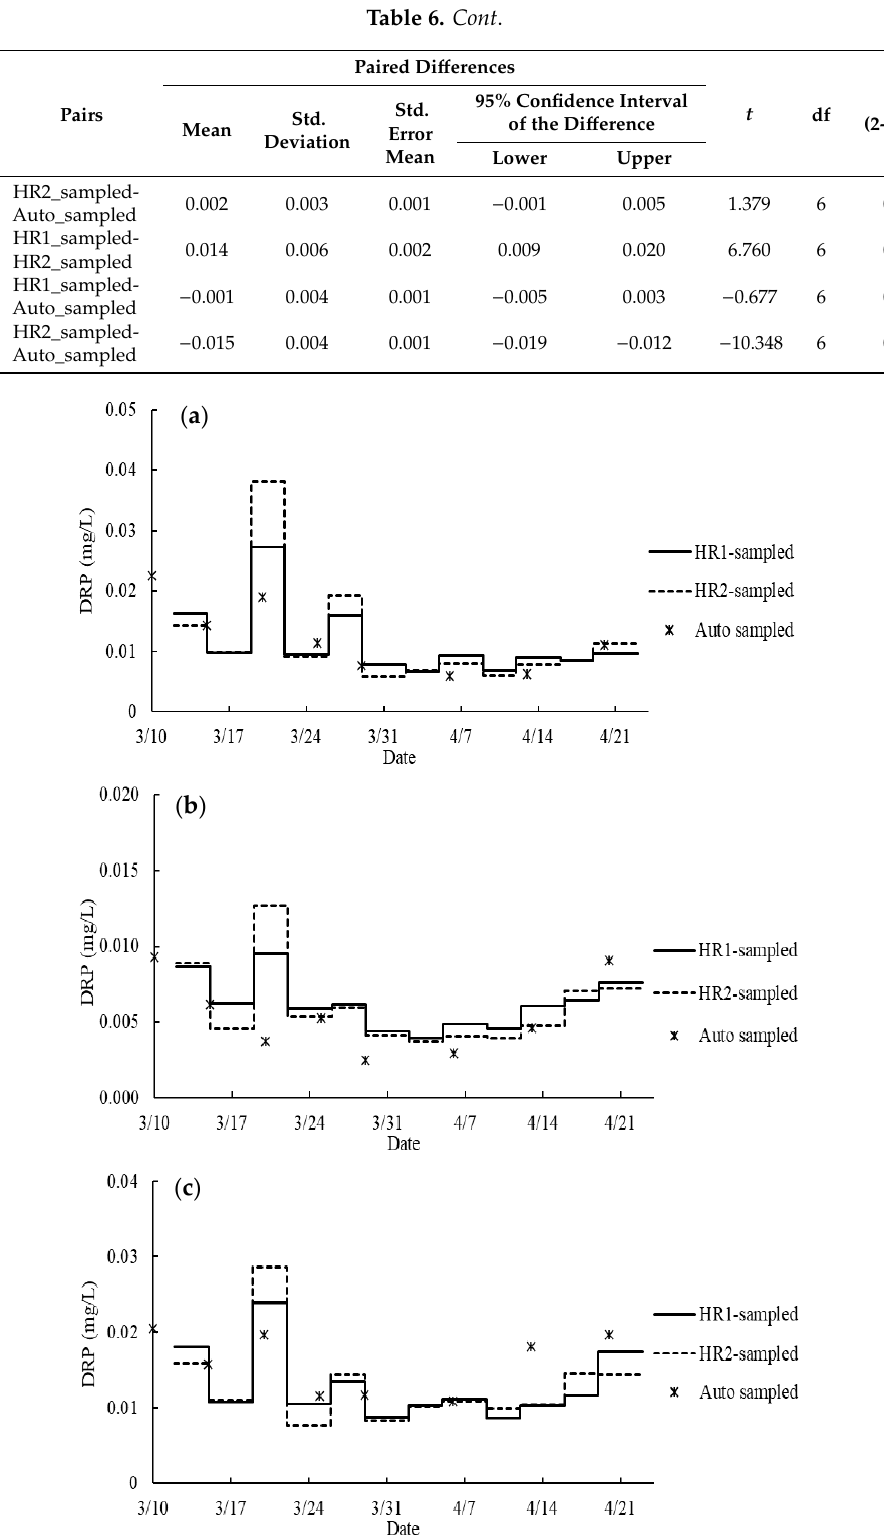
Figure 10. Phosphate concentration of tile water from ( a ) tile #4, ( b ) tile #7 and ( c ) tile #46. The line segments represent the average DRP concentration in each sampling period in 2020 calculated based on the field sampling rates, R F . The scattered dots show the DRP concentration of tile water weekly sampled by the Agridrain system.